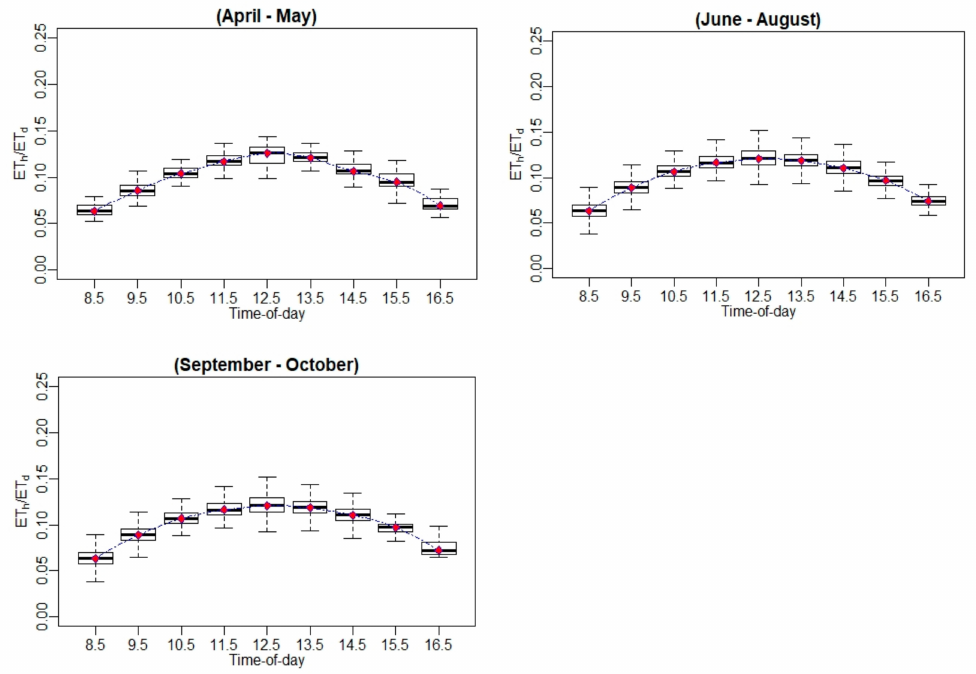
Figure A14. Hourly ET -to-daily ET ratio ( ET h /ET d ) variation using EC